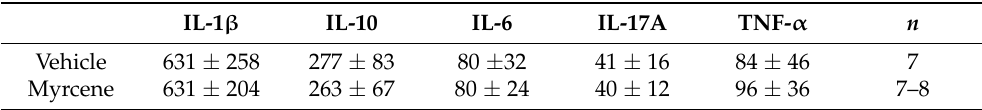
Table 1. Plasma cytokine levels in vehicle compared to myrcene-treated animals. The concentration of inflammatory cytokines (pg/mL) was unaltered by chronic myrcene treatment. Data presented as mean concentration ±